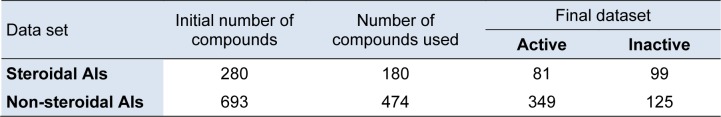
Dataset of steroidal and non-steroidal AIs